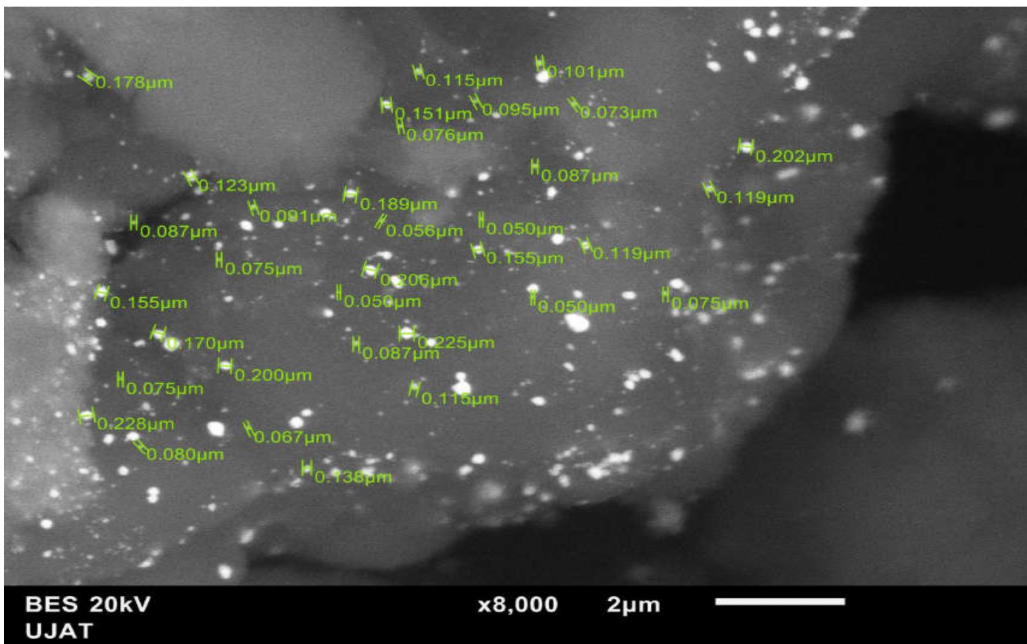
Figure 9. SEM images with BES detector for the nanomaterial